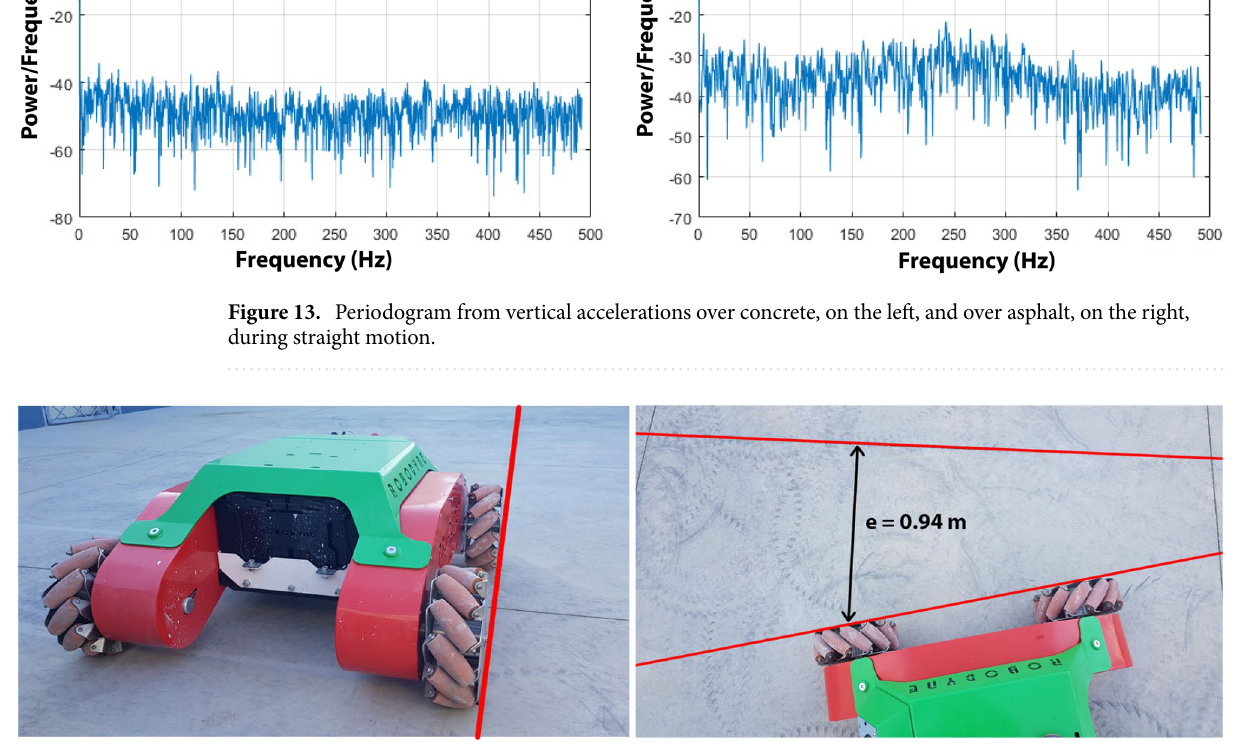
Figure 14. The vehicle positioned at the starting point on concrete, on the left, and the final error at goal, on the right.